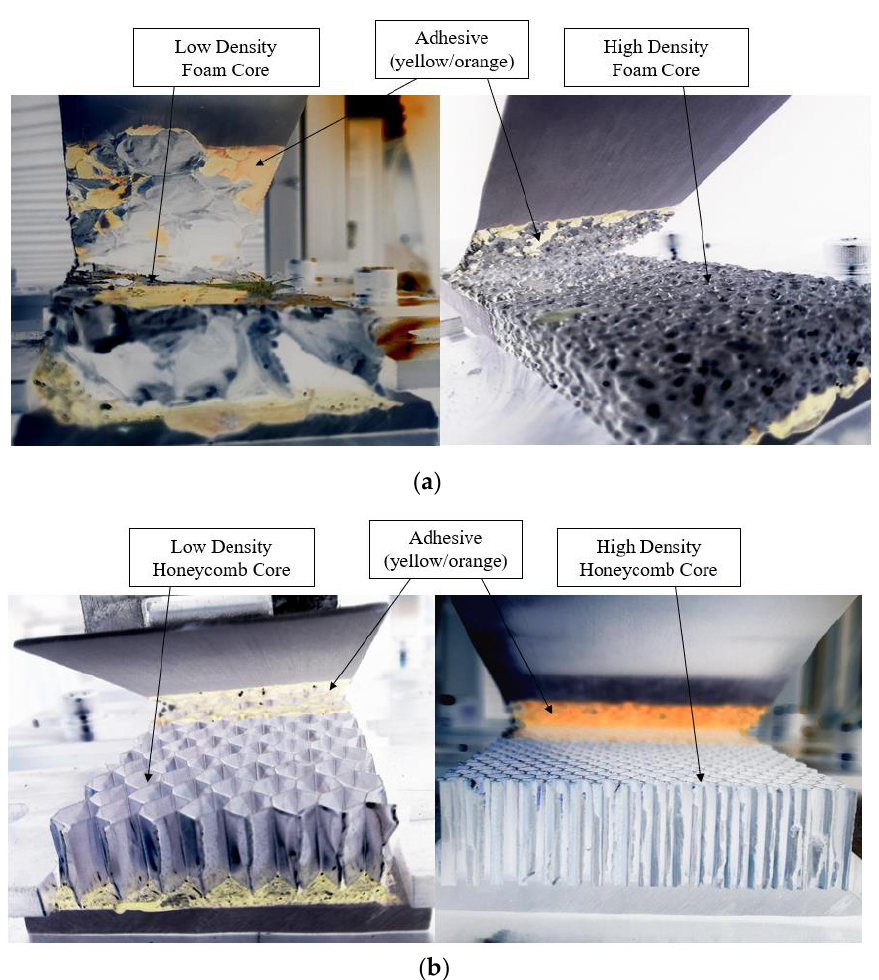
Figure 16. Debonding surface of SCB specimens. ( a ): Face sheet debonding of SCB1 sandwich configuration; ( b ): face sheet debonding of SCB2 sandwich configuration. Complete and partial cohesive failure was predominantly seen in the HDHC and LDHC honeycomb samples, respectively, with a small amount of fiber tear failure in the LDHC samples.